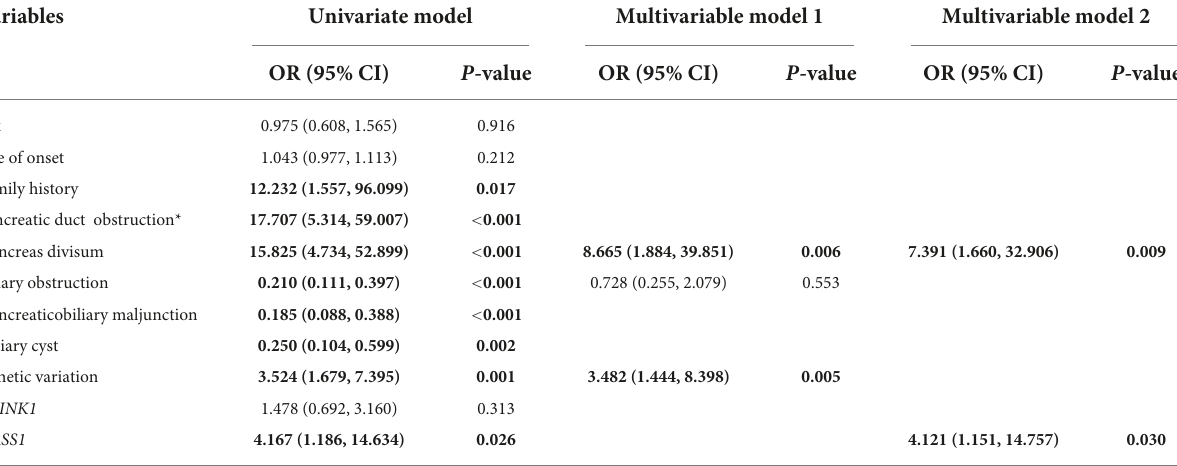
TABLE 2 Logistic regression analysis results for CP risk factors in